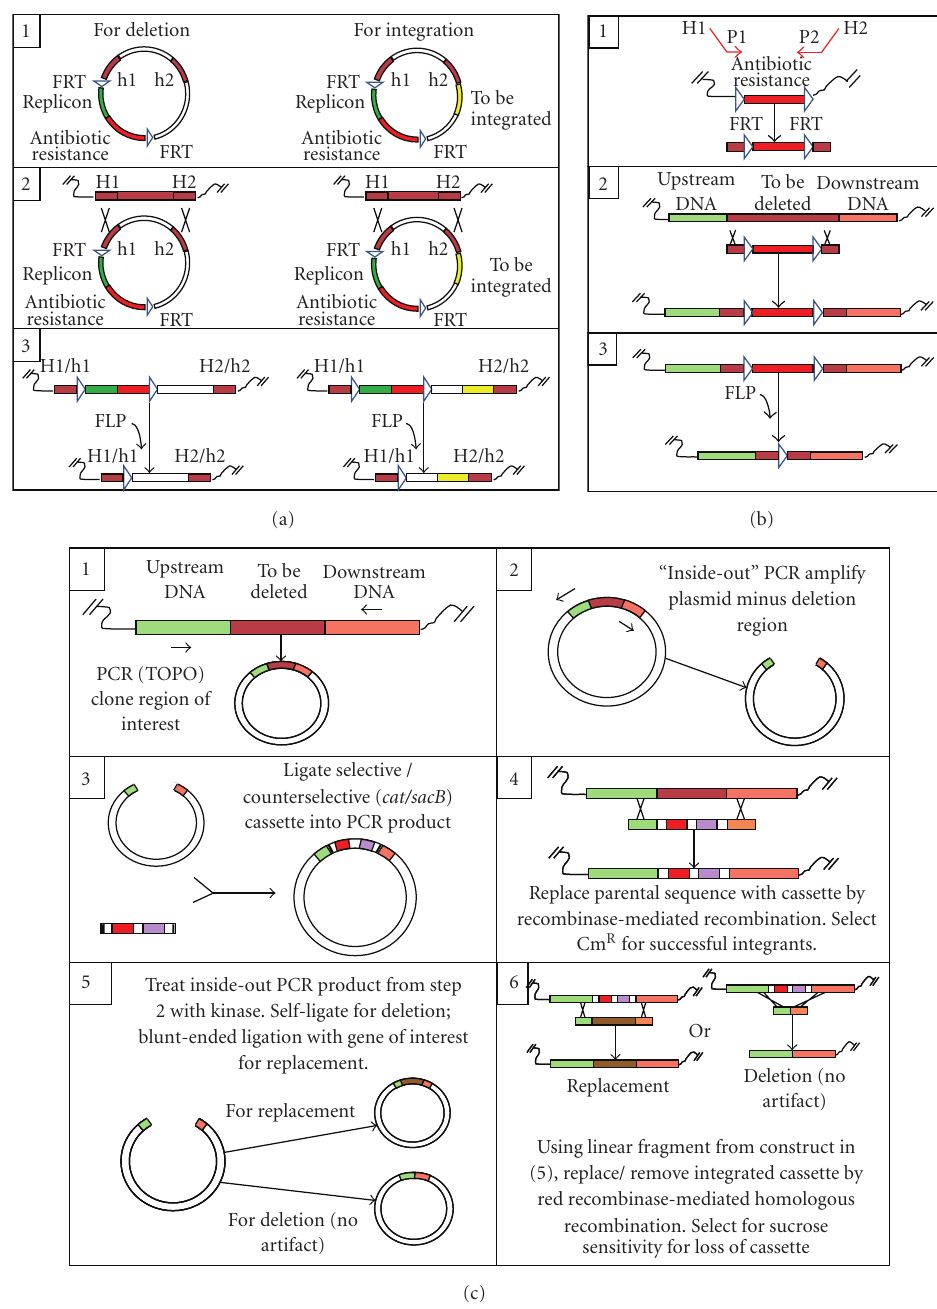
Figure 2: Comparison of three-gene deletion methods in E. coli . These methods can also be used in other enteric bacteria. The first and third methods can also be used for gene integration into the chromosome and promoter replacement for tuning gene expression. 2(a) plasmid- based method . Step 1 is construction of the deletion plasmid containing DNA fragments homologous to the target gene (h1 and h2), a selectable marker, and either a temperature sensitive or conditional replicon. Step 2 is double-crossover recombination; the plasmid cannot replicate in the host strain, and antibiotic-resistant colonies are selected. In step 3, the FRT, replicon, and antibiotic resistance marker are removed by FLP. 2(b) Linear DNA-based method . Step 1 is construction of the linear DNA fragment by PCR (H1-P1 and H2-P2 as